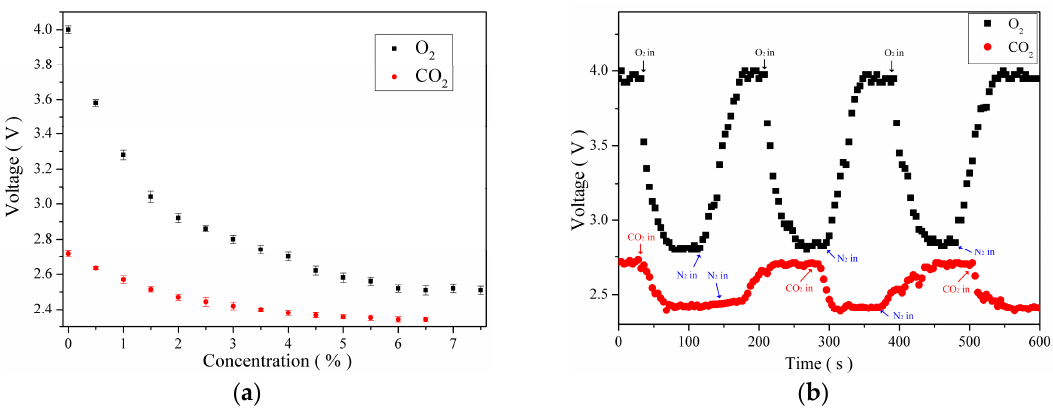
Figure 7. Analysis on the O 2 and CO 2 sensors: ( a ) voltage response curve relative to gas concentration; and ( b ) dynamic response time and recovery time measurement.